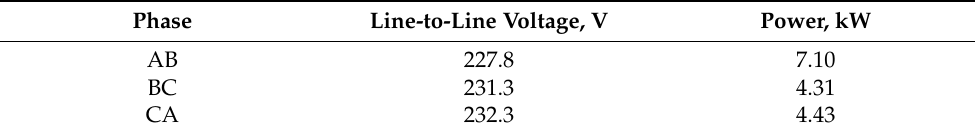
Table 5. Average values of voltage and power in the Gilutongan Island village diesel generator from measurements made on 23 May 2019.